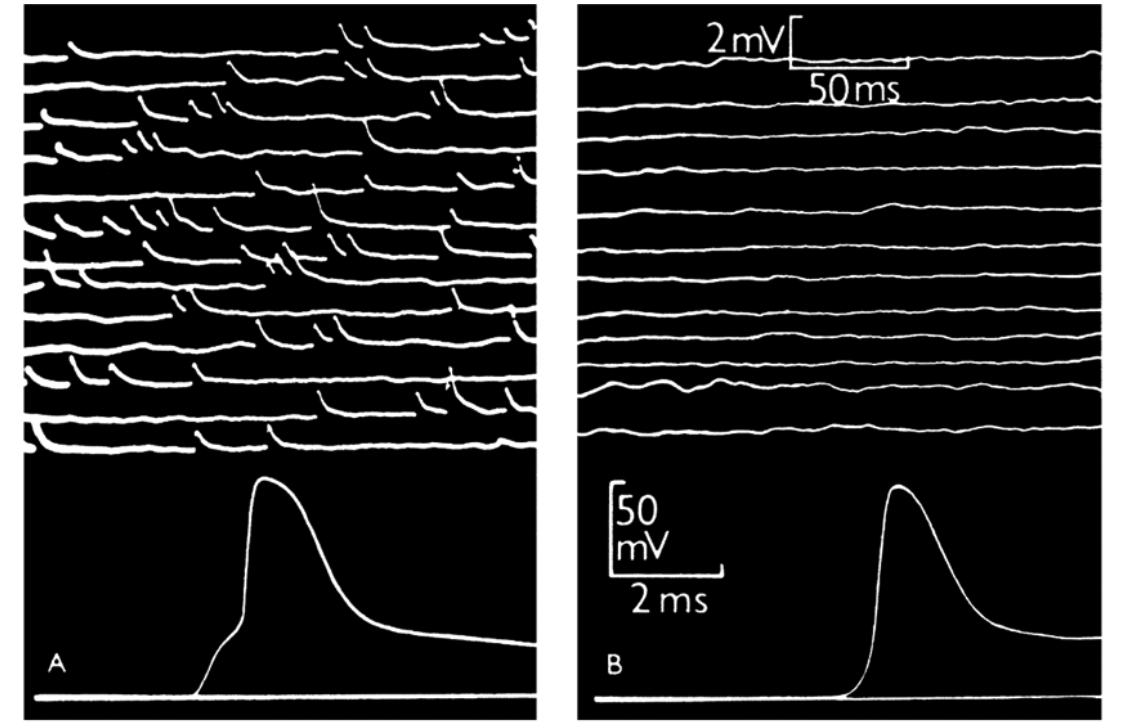
FIGURE 1: Intracellular recording from single muscle fibre of frog . (A) At the motor end-plate. The upper part shows spontaneous miniature end-plate potentials, which are localized at a junction and arise from sudden discharge by a motor nerve ending of packets of acetylcholine, each containing thousands of molecules. The lower part shows a single response to a nerve impulse, which was started by electric shock at the beginning of the trace; the first step of the response is large end-plate potential resulting from synchronous delivery of a few hundred packets of acetylcholine, this leading to full size action potential. (B) Traces recorded in the same muscle fibre, 2 mm away from the end- plate. The upper part shows much attenuated and barely recognizable residues of miniature end-plate potentials. The lower part shows propagated action potential, delayed by conduction over 2 mm distance and not preceded by the end-plate step. From